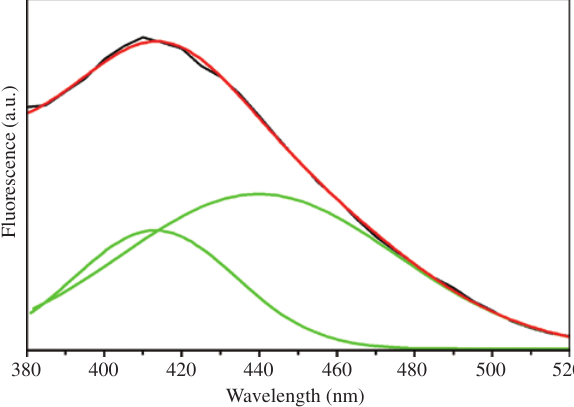
Figure 5: Fluorescence spectrum obtained from aqueous zinc sulfide nanoparticles at room temperature excited at 325 nm.